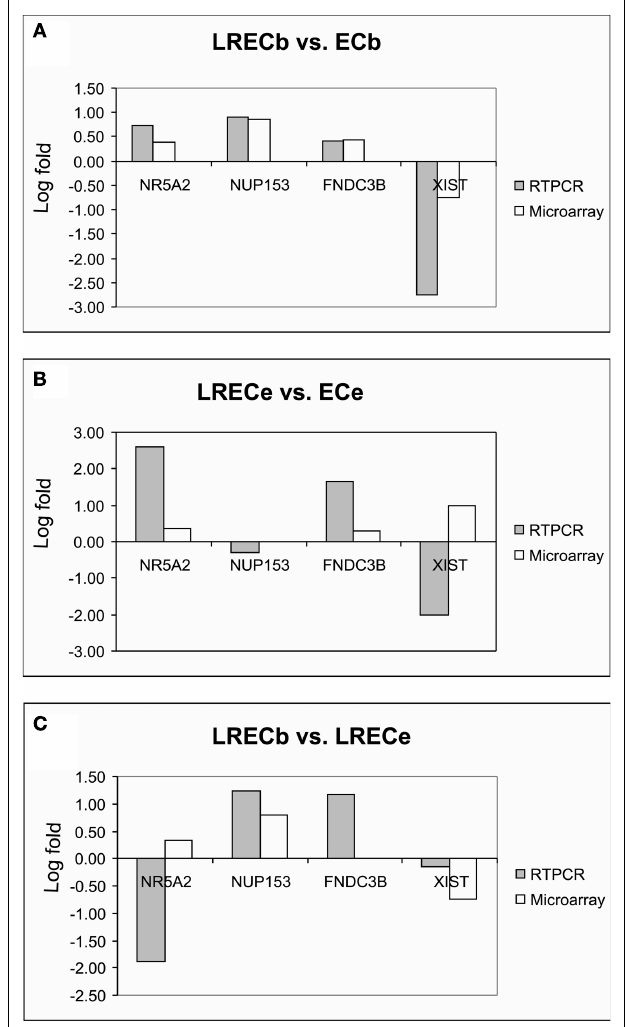
FIGURE 8 | Quantitative RT-PCR and microarray analysis of selected genes. Concordance of gene expression patterns between microarray and qRT-PCR for key genes. (A) LRECb vs. ECb; (B) LRECe vs. ECe; (C) LRECb vs. LRECe. Data are expressed as fold change (log 10 ) relative to indicated comparisons.